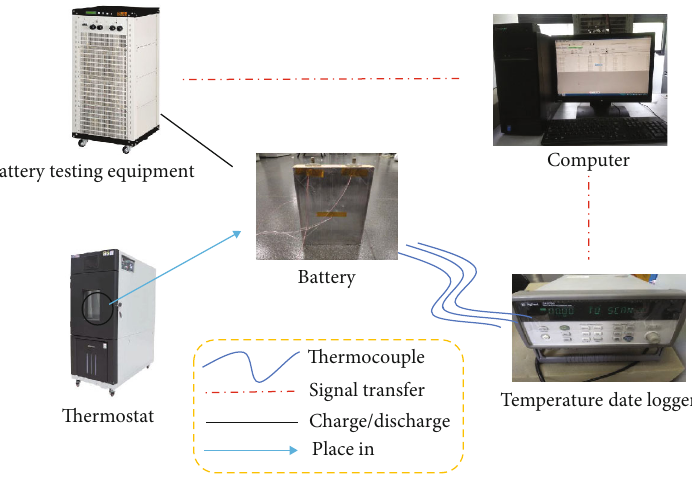
Figure 5: Battery heat production test experimental platform.